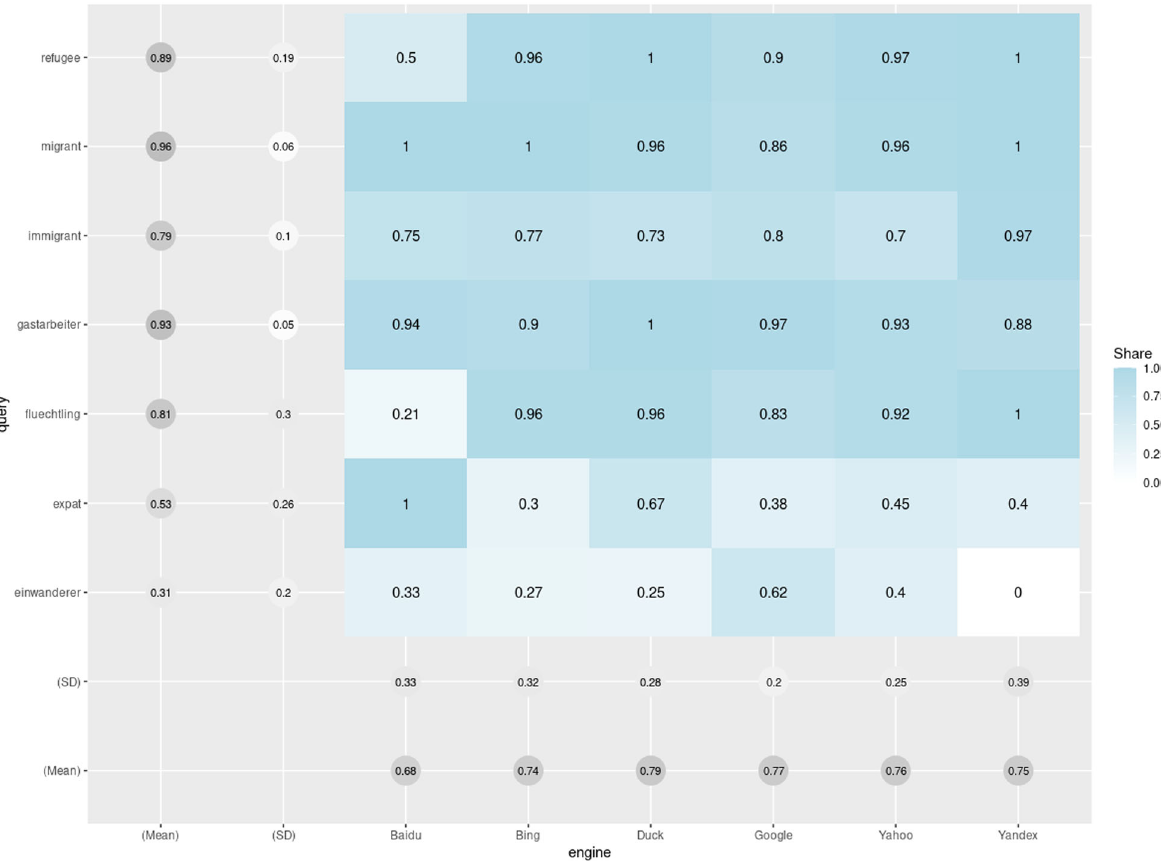
Fig. 6 Share of images with people who appear to be non-white people by engine and